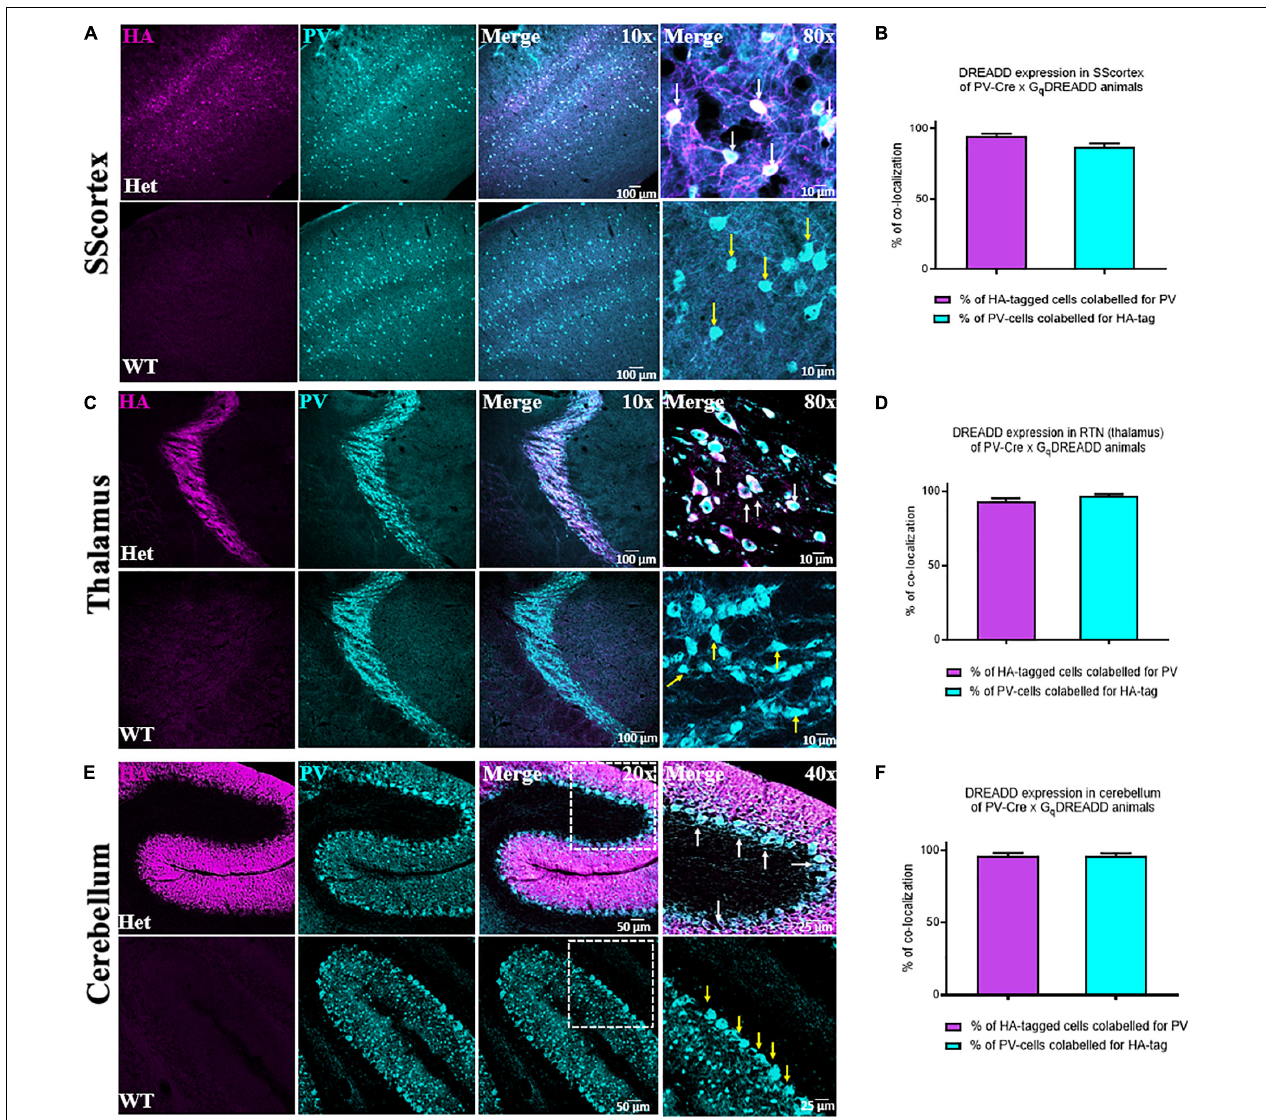
FIGURE 1 | (A,C,E) Confocal images showing the expression of HA-tag in PV+ interneurons in the SScortex, the RTN thalamus and the cerebellum of PV Cre /Gq-DREADD animals, respectively. White arrows in merged images represent co-localized cells. Yellow arrows indicate PV positive neurons, which are immunonegative for HA. (B,D,F) Percentage of co-localization of HA-tag and PV in neurons in the SScortex, the RTN thalamus, and the cerebellum, respectively. Immunolabelled cells in the SScortex and the cerebellum were counted at 10 × magnified confocal images whereas in the RTN thalamus cells were counted using 40 × images (Het = PV Cre /Gq-DREADD offspring from homozygous PV-Cre female and heterozygous hM3Dq-flox male; WT = Non-DREADD wild type control